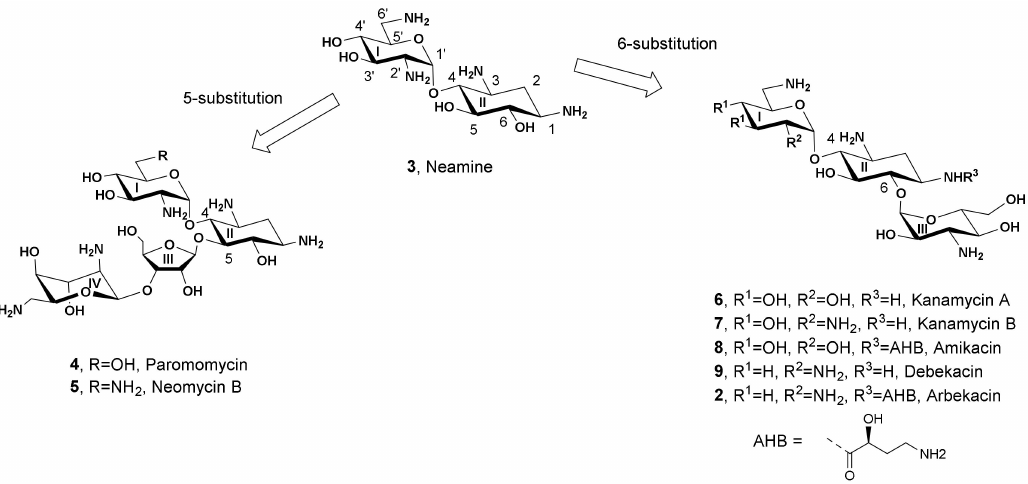
Figure 2. Structures of neamine and several representative aminoglycosides. The neamine core is composed of ring I and ring II.